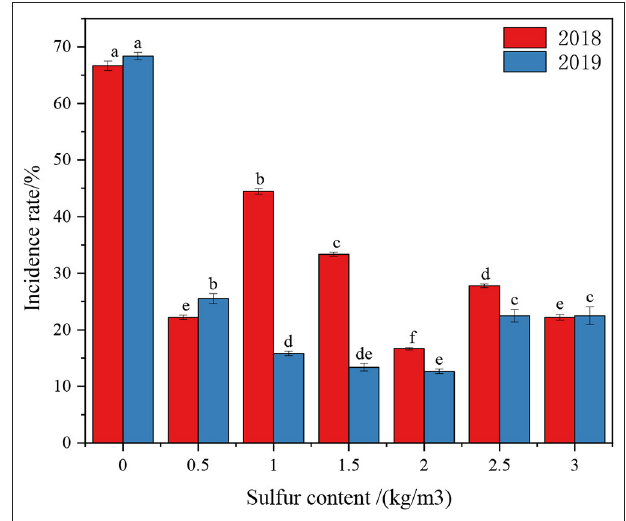
FIGURE 2 | Effects of different sulfur treatments on the incidence rate of kiwifruit canker. Different letters indicate statistically significant differences ( p < 0.05) between groups in each column. The same as